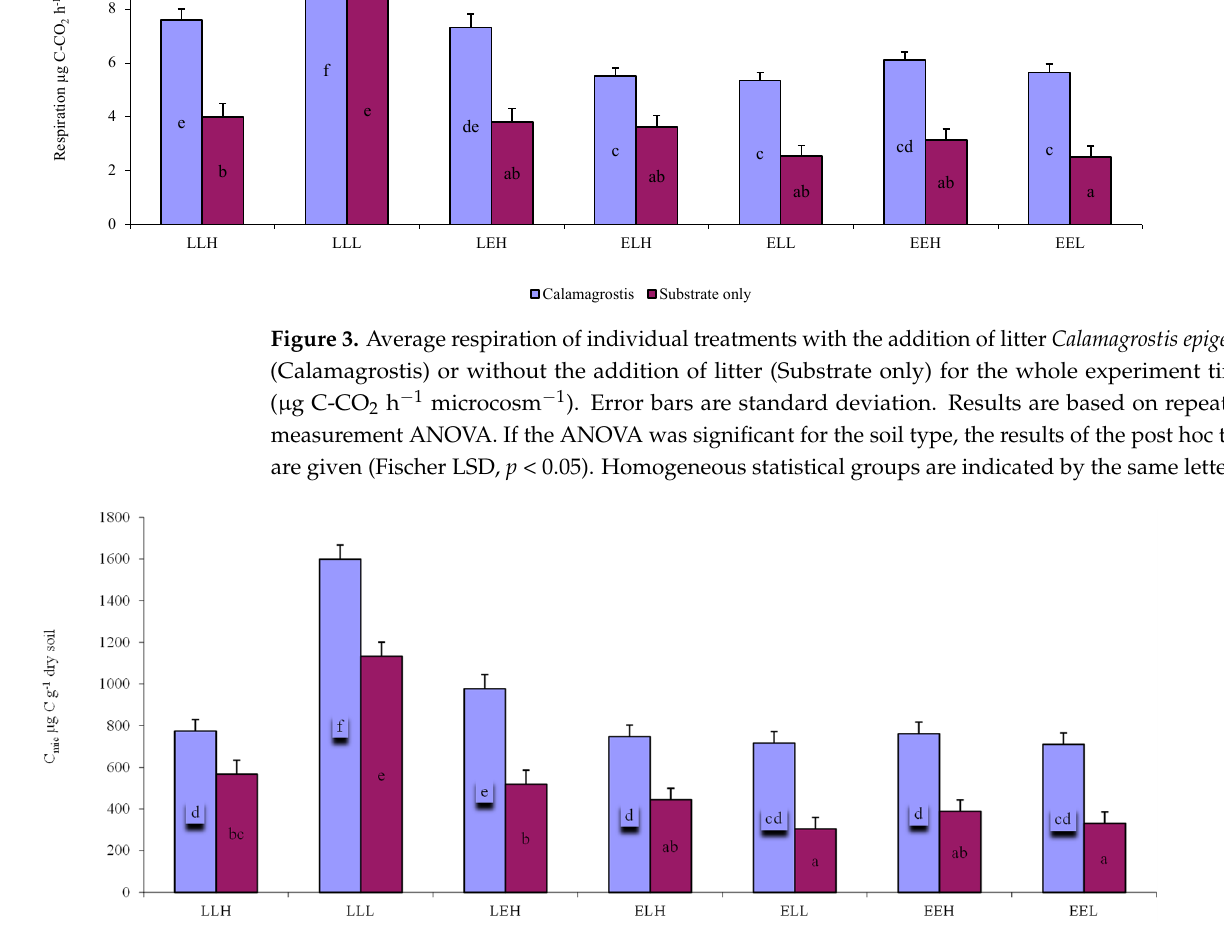
Figure 4. Average microbial biomass carbon (C mic ) per gram of dry soil at individual treatments ( µ g C g − 1 ) with the addition of Calamagrostis epigejos litter (Calamagrostis) or without the addition of litter (Substrate only). Error bars are standard deviation. Results are based on one-way ANOVA. If the ANOVA was significant for the soil type, the post hoc results are given (Fischer LSD, p < 0.05). Homogeneous statistical groups are indicated by the same letters.